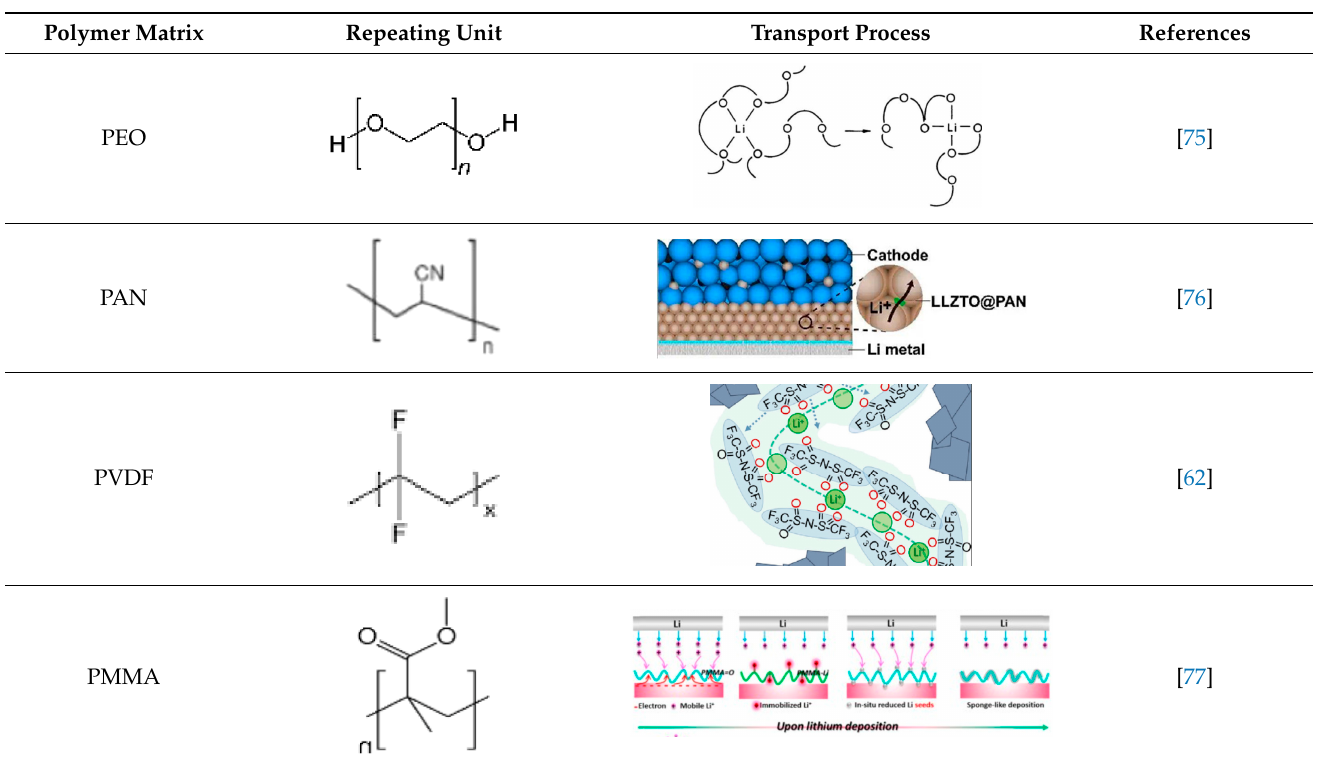
Table 1. Summarized for the structure, properties and applications of the polymer matrix.